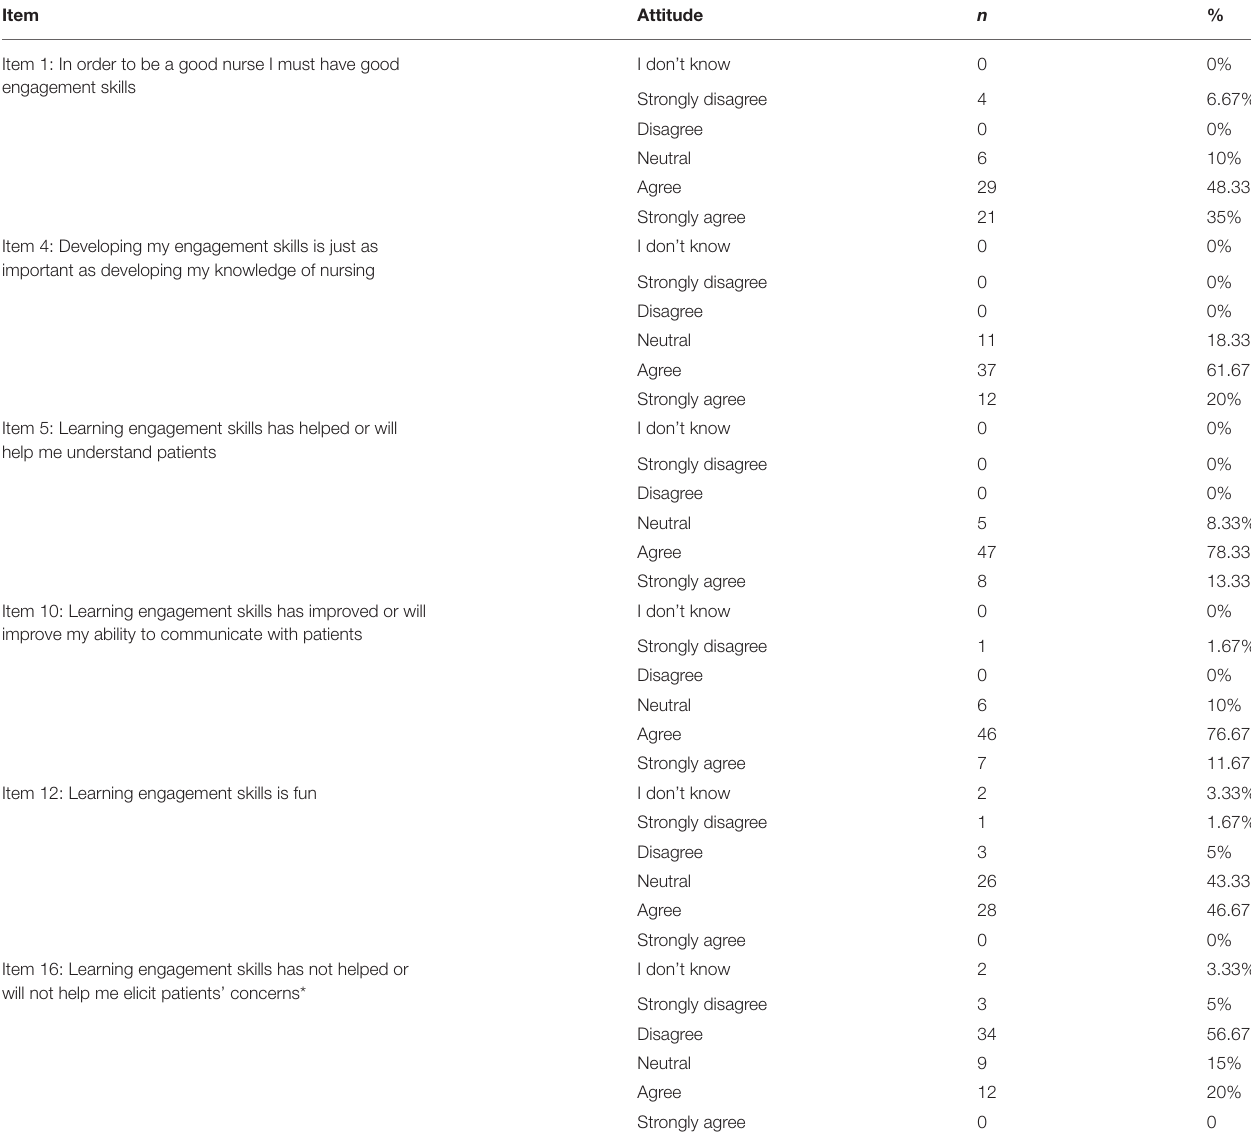
TABLE 6 | Percentages of each response for each item on views on the learning of engagement skills (Theme 3). Item Attitude n